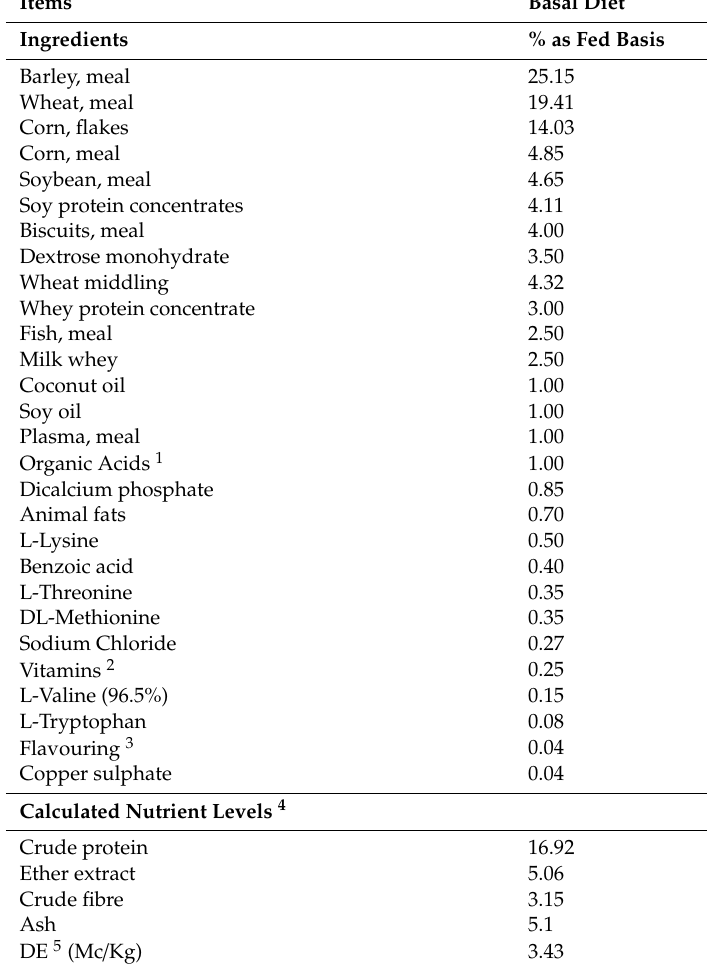
Table 1. Composition of the basal experimental diet. In the tributyrin (TRIB) group, 0.2% of corn was substituted with 0.2%